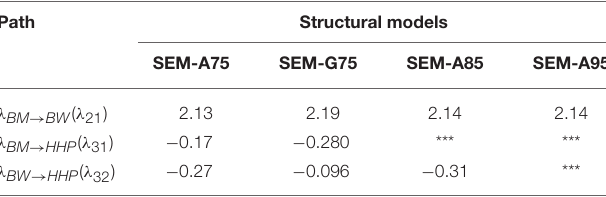
TABLE 2 | Estimates of three causal structural coefficients ( λ ) derived from four different structural